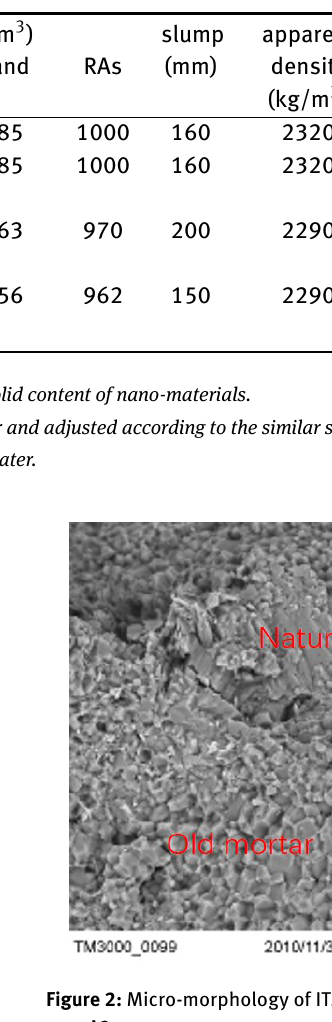
the fluidity of concrete. Table 3 showed the mix proportion and nano-strengthening solution of